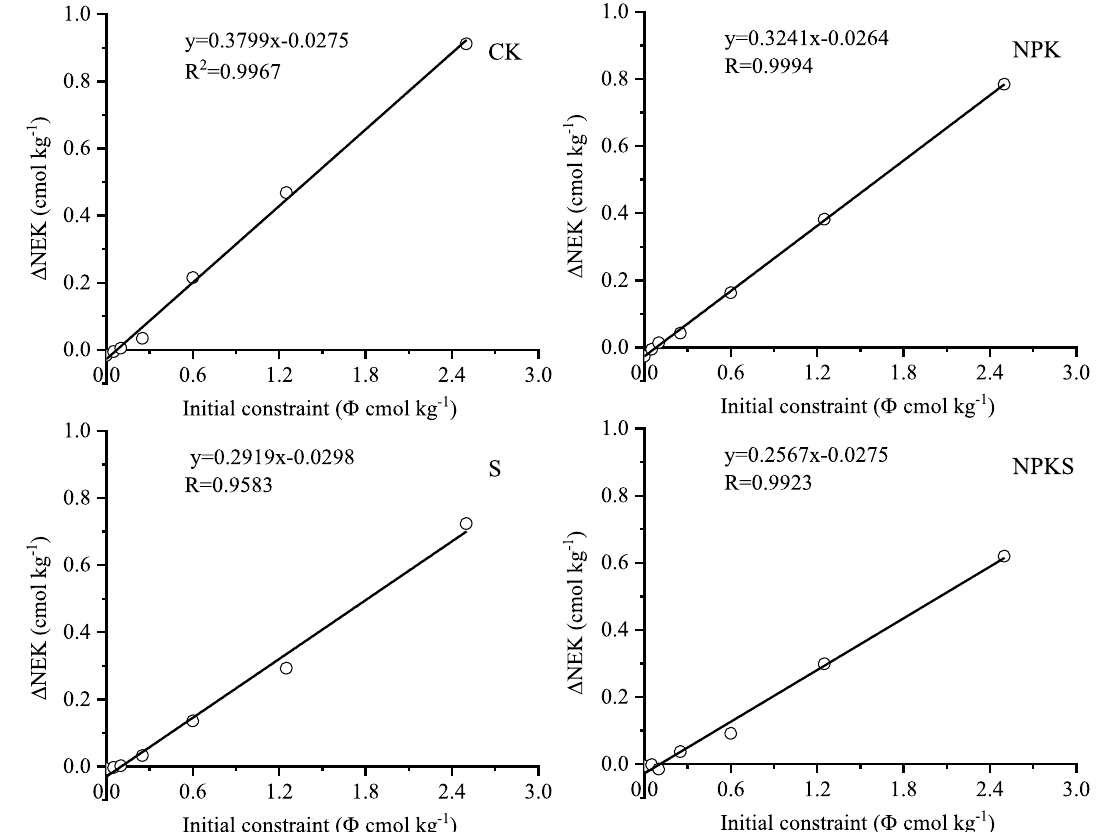
Figure 6. Plots of ∆NEK vs. initial constraint K for tested soils with and without straw return. (CK, no fertilization; NPK, mineral fertilizing; S, straw 6000 kg h m −2 ; NPKS, NPK with straw 6000 kg h m −2 ; ∆NEK, amount of K adsorbed or release due to non-exchangeable pool of K during